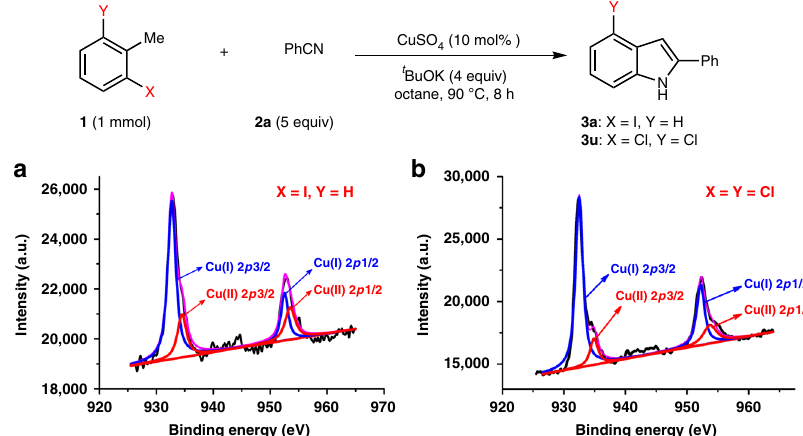
Fig. 8 Detection of Cu(II) and Cu(I) by XPS experiments. a To 3a when X = I and b to 3u when X = Cl. XPS Instrument type: Thermo ESCALAB 250Xi; X- ray excitation source: monochromatic Al Ka (hv = 1486.6 eV), power 150 W, X-ray beam 500 μ m; Energy analyzer fi xed transmission energy: 30